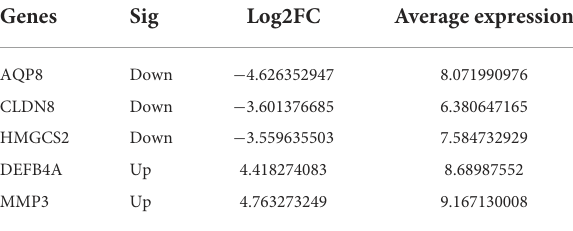
TABLE 4 Details of genes in diagnostic